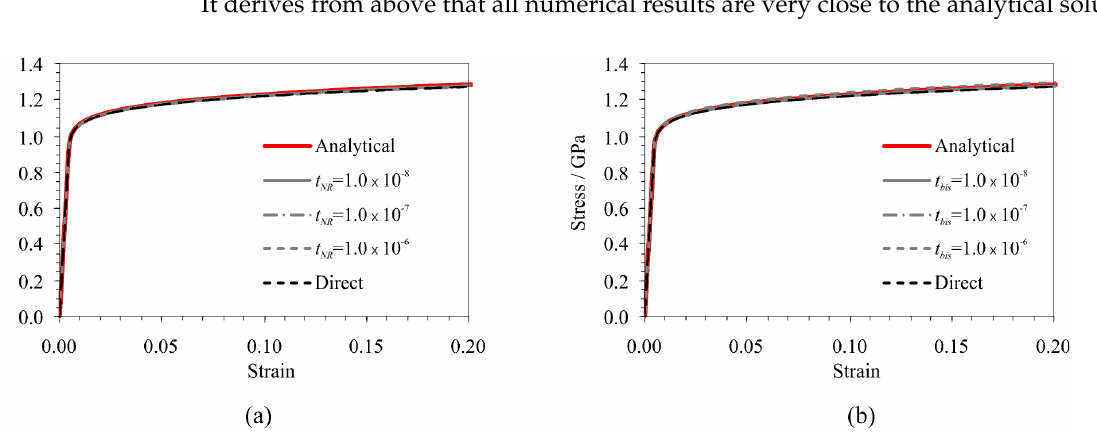
Figure 7. Stress-strain relation in the triangle obtained by: ( a ) Newton–Raphson; and ( b ) bisection iterative procedure for evaluation of plastic correction parameter Γ .